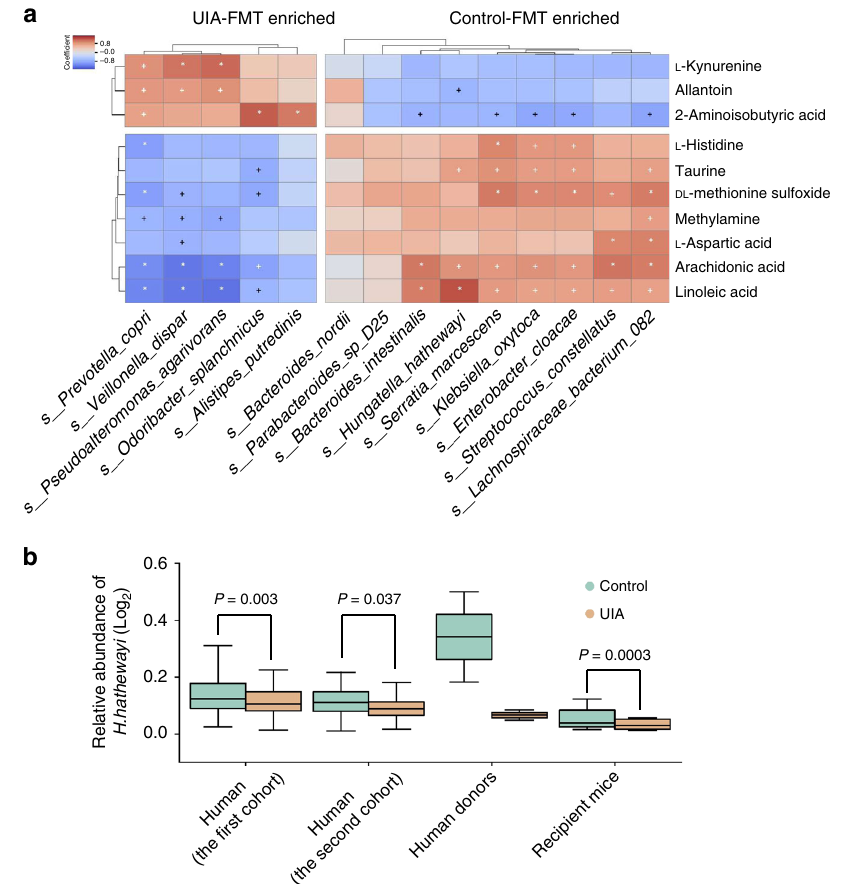
Fig. 7 Associations of gut microbial H. Hathewayi with circulating taurine in mice. a Heat maps of Spearman ’ s rank correlation coef fi cients between 10 altered metabolites and 14 differentially abundant gut microbial species. + P < 0.05, * P < 0.01. Pairs with low correlations (| r | < 0.4) are not shown ( n = 10). b Relative abundances of H. hathewayi in two cohorts of UIA patients ( n = 100; n = 40), Human donors ( n = 2), and mice that received fecal microbiota transplantation (FMT) from UIA patients or controls ( n = 10). Two-tailed Wilcoxon rank-sum test. In all box plots, boxes represent the interquartile ranges (IQRs) between the fi rst and third quartiles, and the line inside the box represents the median; whiskers represent the lowest or highest values within 1.5 × IQR from the fi rst or third